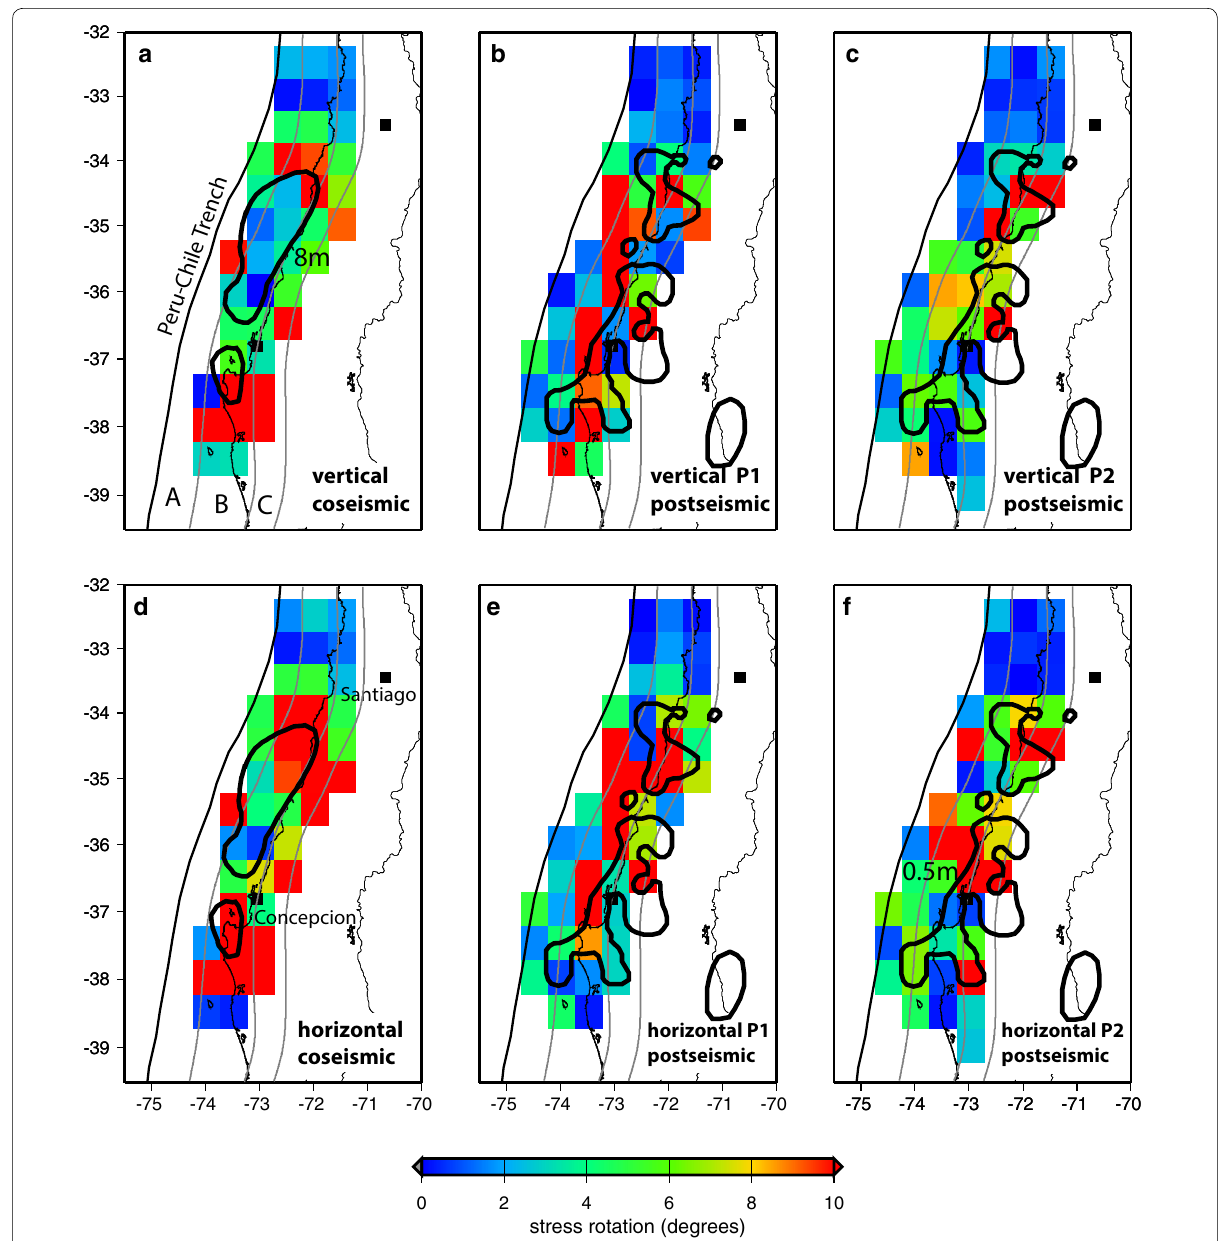
Fig. 2 Stress rotations following the 2010 M8.8 Maule earthquake. a Vertical coseismic rotation, the change between the pre-mainshock (1977-5- 20–2010-2-27) and first postmainshock (2010-2-27–2010-4-30) time periods. Thick black lines indicate the 8-m contour of the mainshock slip model of Moreno et al. (2012), b vertical postseismic rotation P1, between the first and second (2010-4-30–2010-8-31) postmainshock time periods. Thick black lines indicate the 0.5-m contour of the postseismic slip model of Lin et al. (2013), c vertical postseismic rotation P2, between the second and third (2010-8-31–2015-9-16) postmainshock time periods, d horizontal coseismic rotation, e horizontal postseismic rotation P1, f horizontal post- seismic rotation